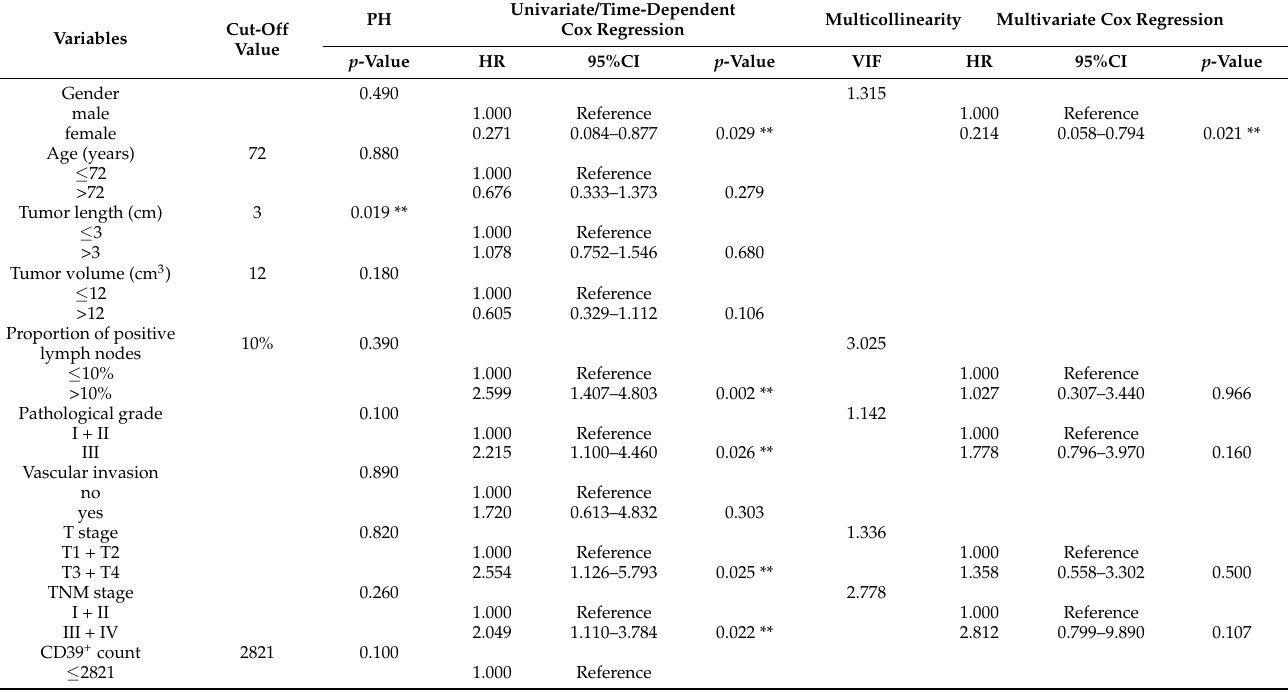
Table 2. Univariate and multivariate Cox regression analysis of 67 ESCC